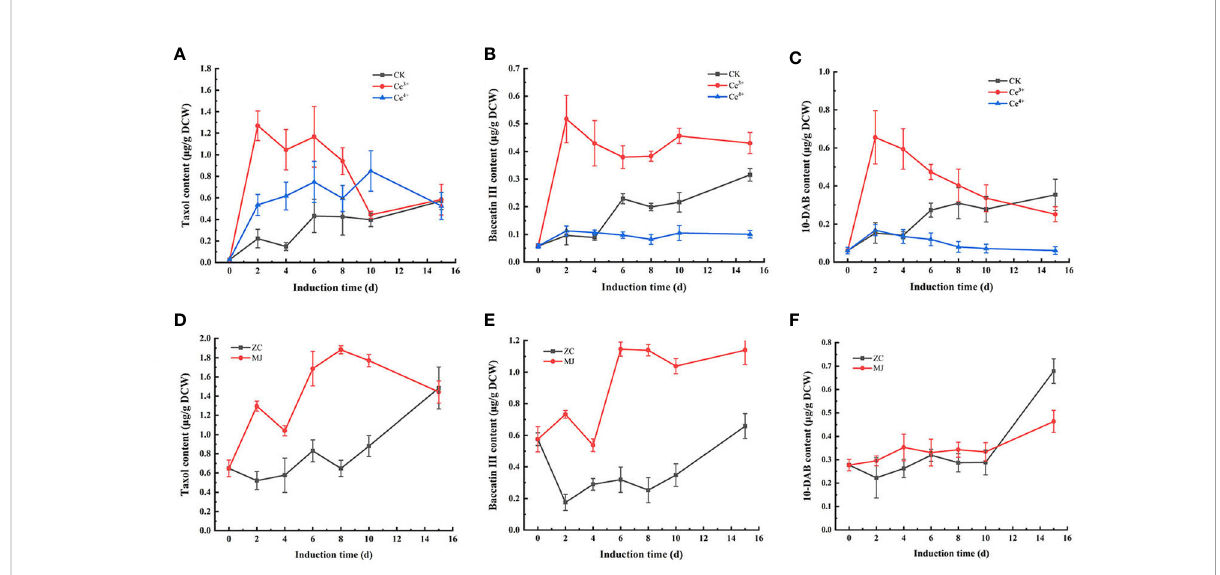
FIGURE 1 Changes of taxanes content including taxol (A, D) , baccatin III (B, E) , 10-DAB (C, F) in T. mairei cells elicited by Ce 3+ , Ce 4+ and MJ. The sample ID of Ce 3+ , Ce 4+ and MJ respectively represented the samples elicited by Ce 3+ , Ce 4+ and MJ, CK and ZC represented unelicited samples